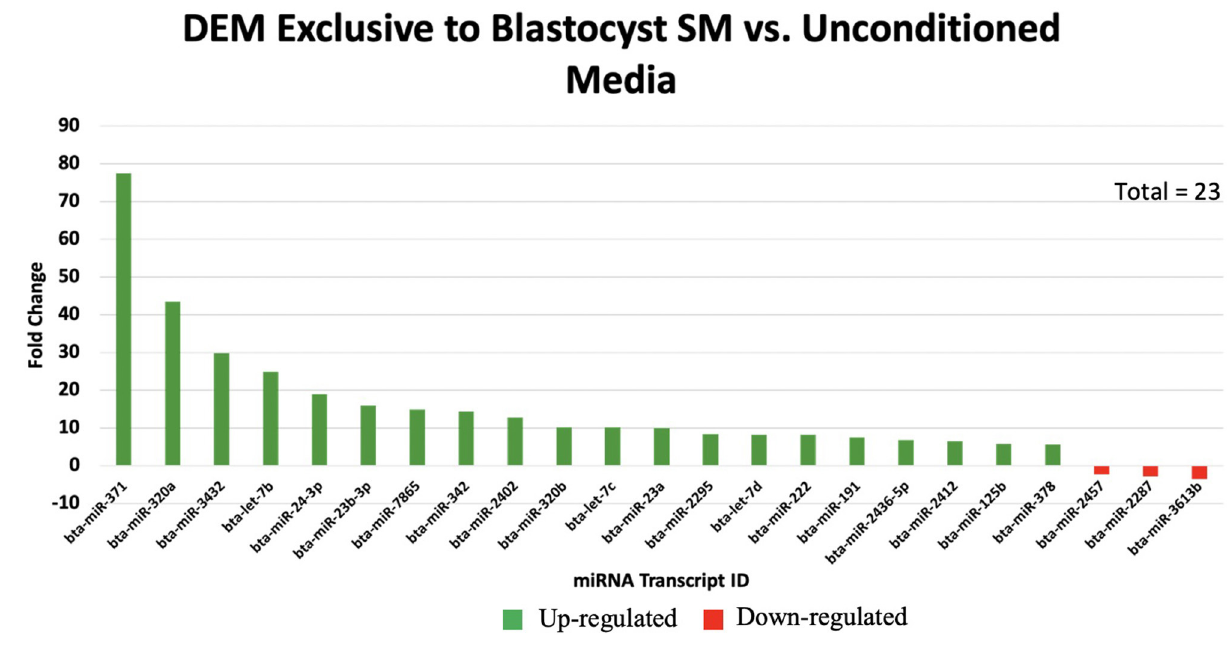
Six miRNAs were upregulated (bta-miR-2281, bta-miR-2900, and the degree of upregulation increased from one condition